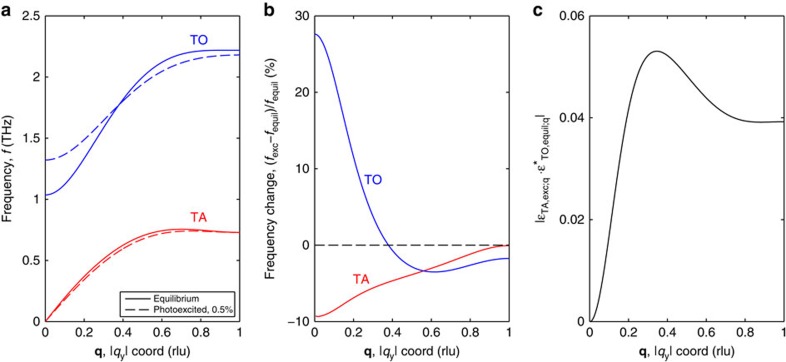
Comparison of calculated transverse optical (TO) and transverse acoustic (TA) dispersions at equilibrium and under 0.5% photoexcitation.(a) Calculated dispersions (TA in red and TO in blue) for PbTe along the Δ direction (marked in reciprocal lattice units, rlu) in the (1 3) zone at both equilibrium (DFT, solid lines) and with 0.5% photoexcitation (CDFT, dashed lines). (b) Relative (percentile) changes in frequency between the DFT and CDFT calculations for both the TO (blue) and TA (red) phonon branches along the Δ. The TA modes experience a softening in frequency across the entire wavevector direction on photoexcitation whereas the TO modes harden dramatically near zone centre and softens near zone edge. (c) Projection of the calculated excited state TA branch eigenvector onto the calculated equilibrium state TO branch eigenvector along the same Δ line. The projection represents the degree of equilibrium TO character that has been translated into the TA modes on photoexcitation and thus the amount of mode-mixing that has occurred. Note that such renormalization of the frequencies and eigenvectors will only result in excitation of two-phonon overtone and combination modes if it is sudden compared with the phonon period.